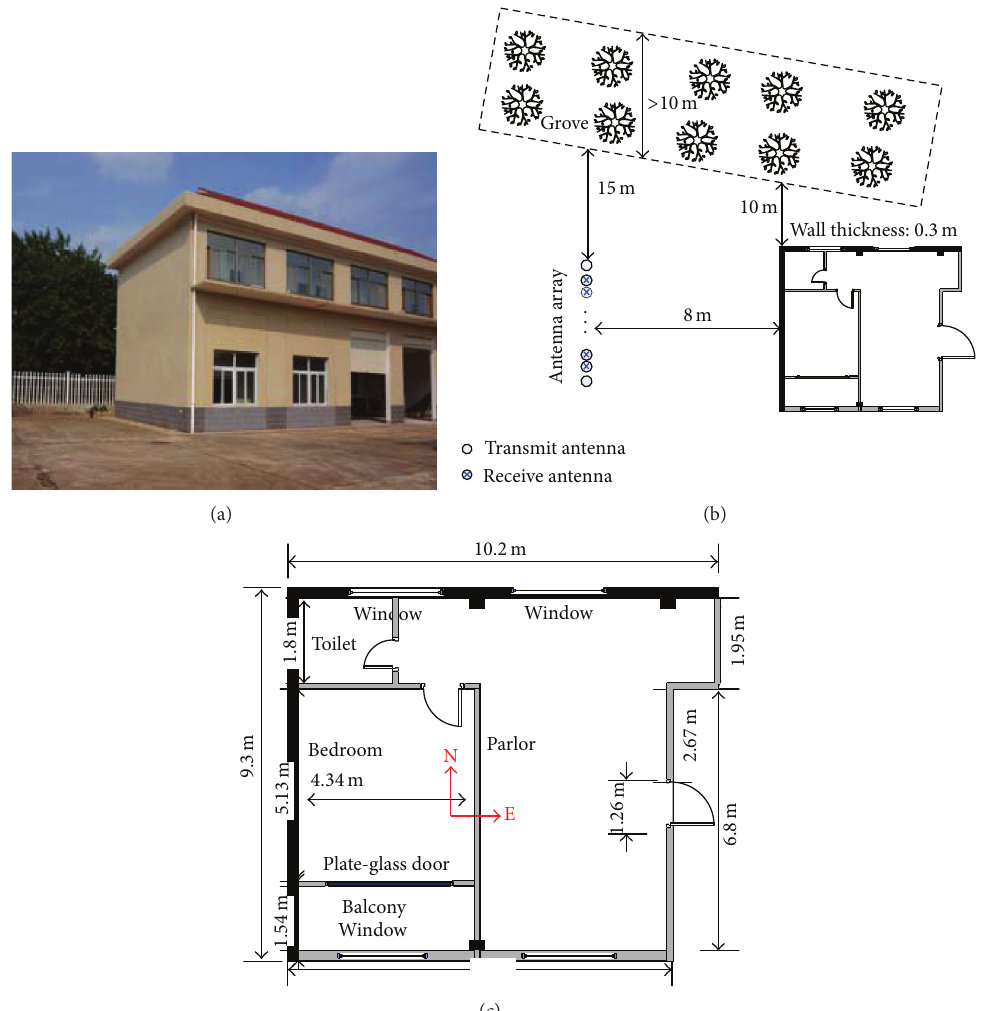
Figure 8: Experimental imaging geometry and scene. (a) Photograph of the building. (b) Geometry of antenna array with the cinderblock building. (c) Configuration inside the building.